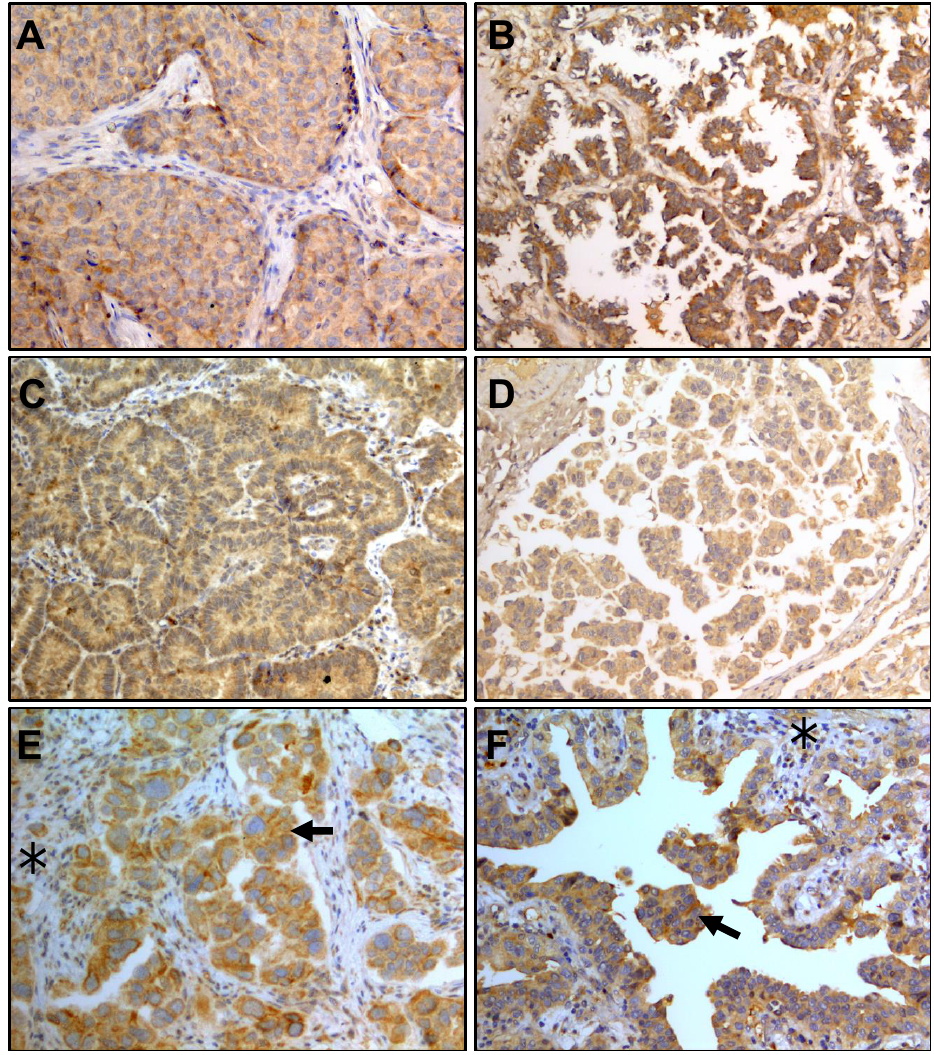
Figure 1. Expression of IL-6 in lung adenocarcinoma histologic subtypes. ( A ) solid, ( B ) lepidic, ( C ) papillary, and ( D ) micropapillary. ( E , F ) Comparison between tumor ( ← ) and stroma (*) staining is shown. Magnification: 200×.